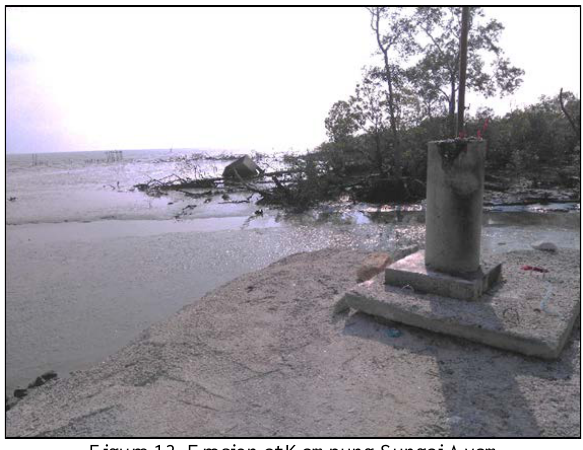
Figure 13. Erosion at Kampung Sungai Ayam